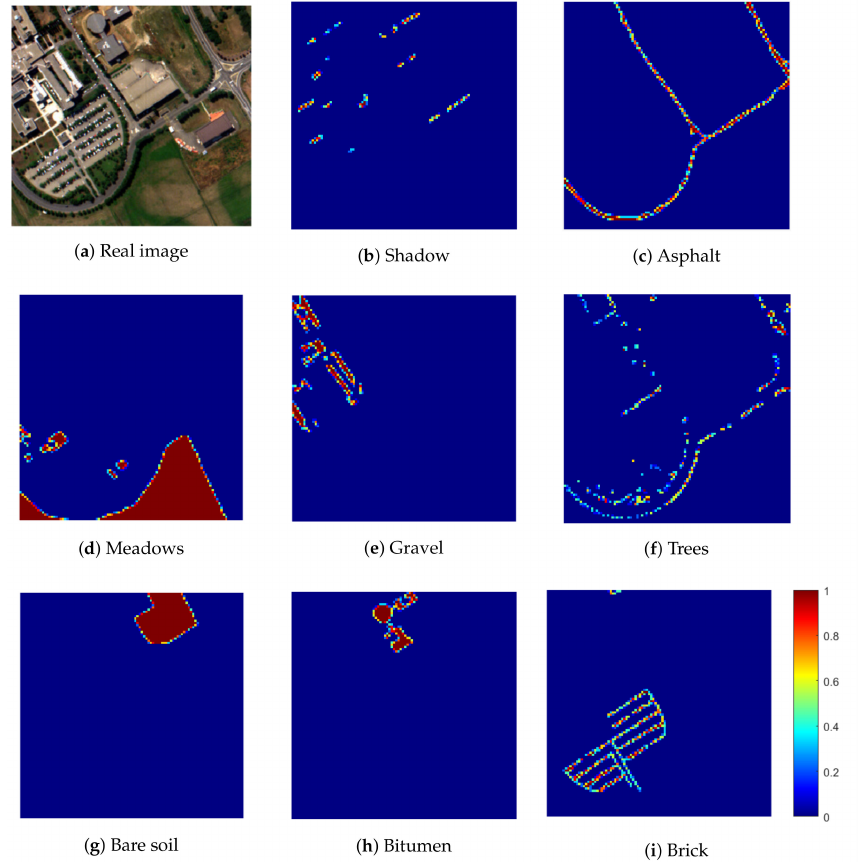
Figure 9. Abundances maps of the different classes used in Pavia university hyperspectral